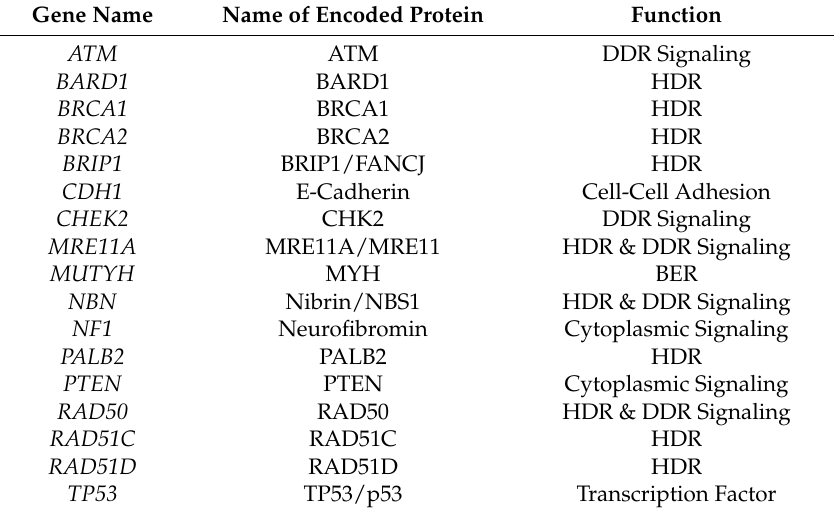
Table 2. List of genes typically on large breast cancer-specific testing